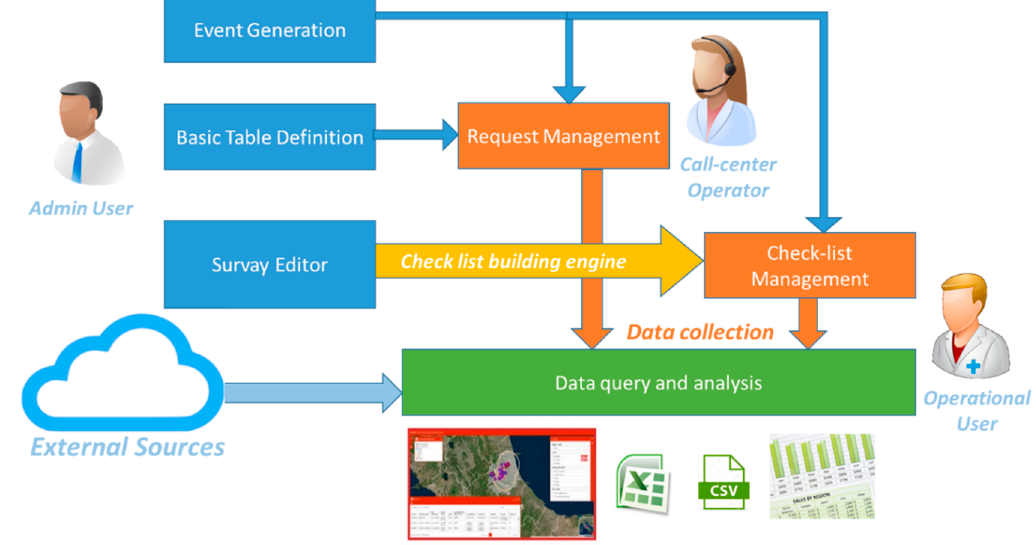
Figure 2. Veterinary Information System for Non-Epidemic Emergencies (SIVENE) software workflow chart. The principal application features are organized in a software workflow chart with indication of different type of users.